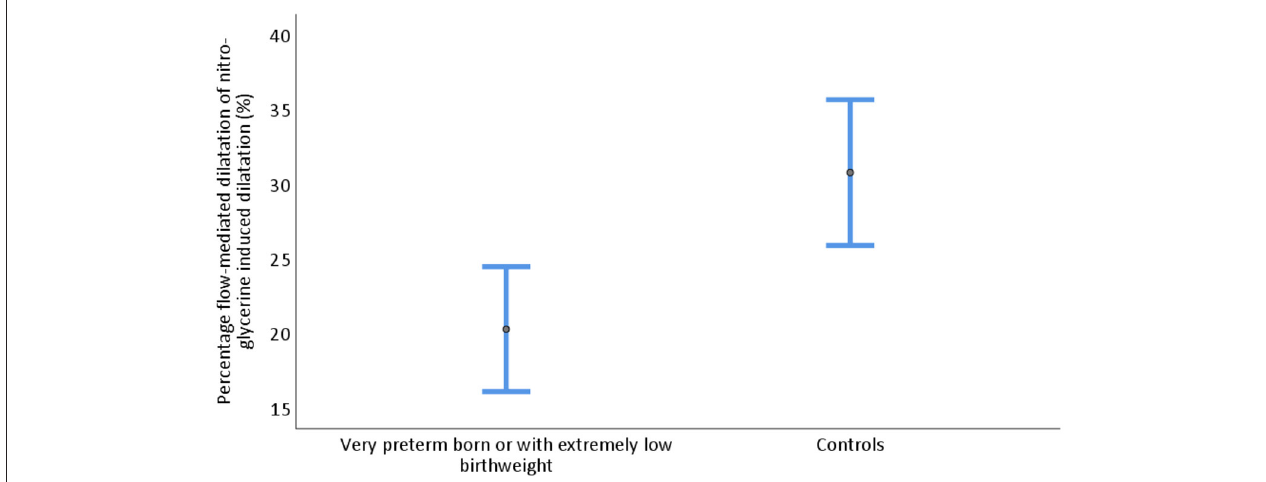
FIGURE 5 | Endothelial-dependent dilatation capacity measured as flow-mediated dilatation in percent of nitroglycerine induced dilatation of the brachial artery in young adults born very preterm or with extremely low birthweight (PB/ELBW) and term-born controls presented as mean with 95% CI. Endothelial-dependent capacity was 20.1% (95% CI 16.1, 24.5) for PB/ELBW and 30.8% (95% CI 25.9, 35.6) for controls.